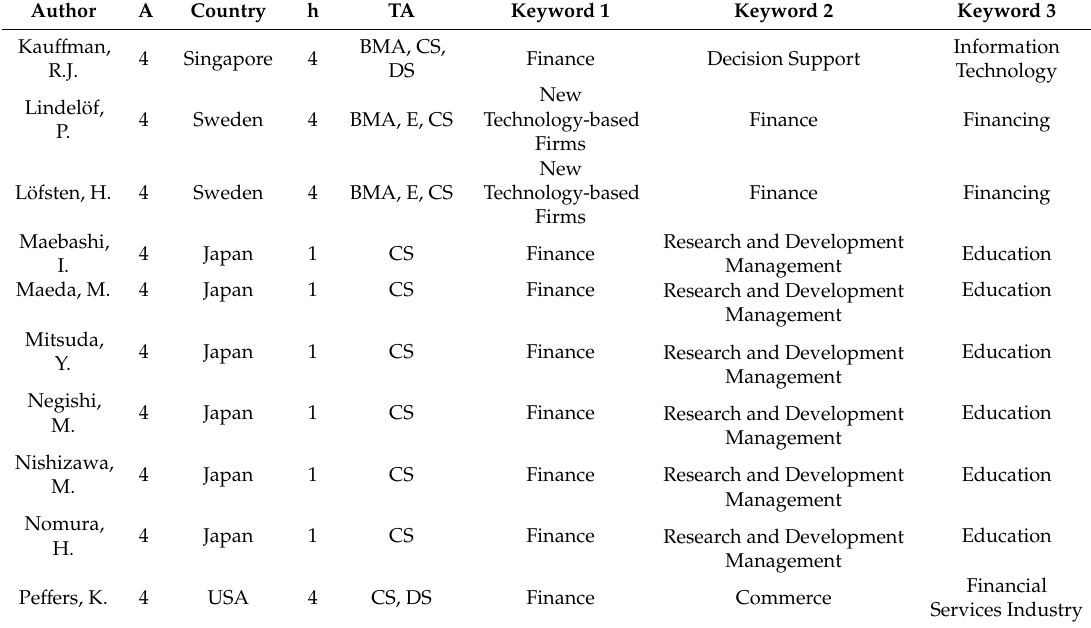
Table 12. Top 10 Authors: main thematic areas and keywords